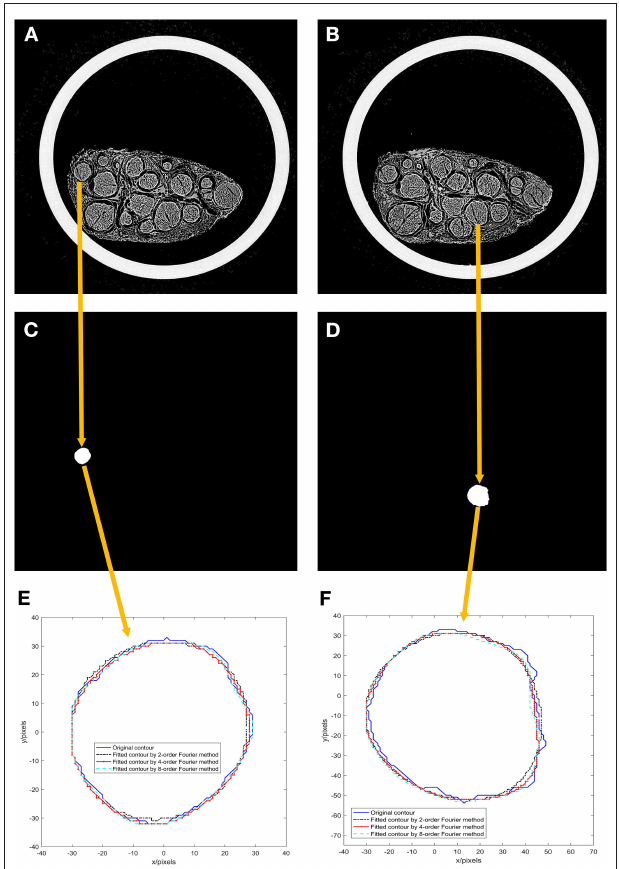
FIGURE 5 | Results of experiment 2. (A) 1st image of the 522 scanned sequence images of the specimen; (B) 46th image of the 522 scanned sequence images of the specimen; (C) A binarized image of the 1st scanned image; (D) a binarized image of the 46th scanned image; (E) Fourier models of the 1st scanned image; (F) Fourier models of the 46th scanned image.